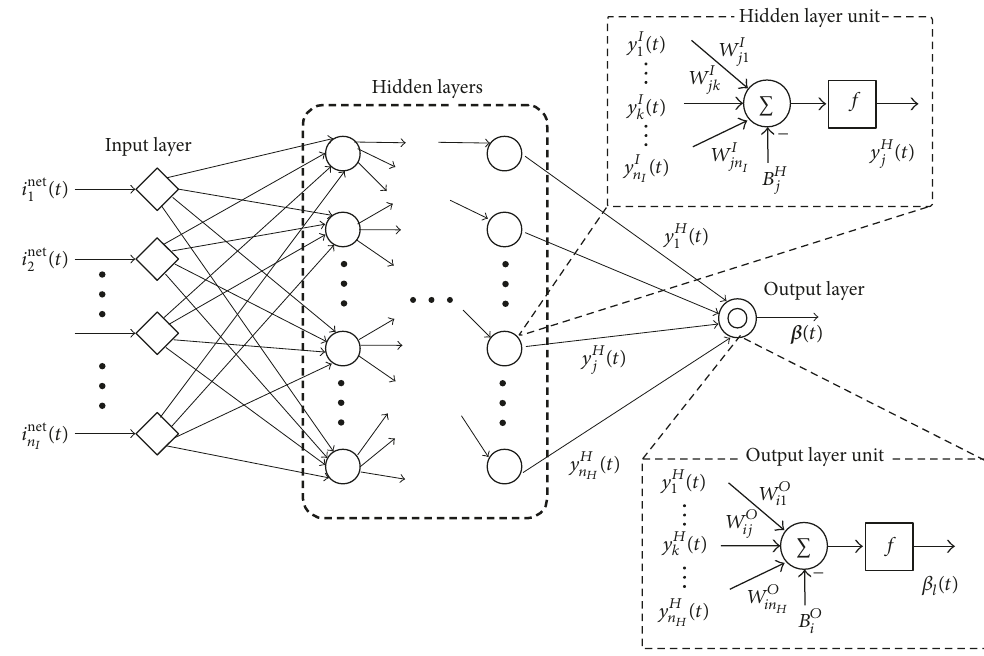
Figure 5: Structure of the multilayered